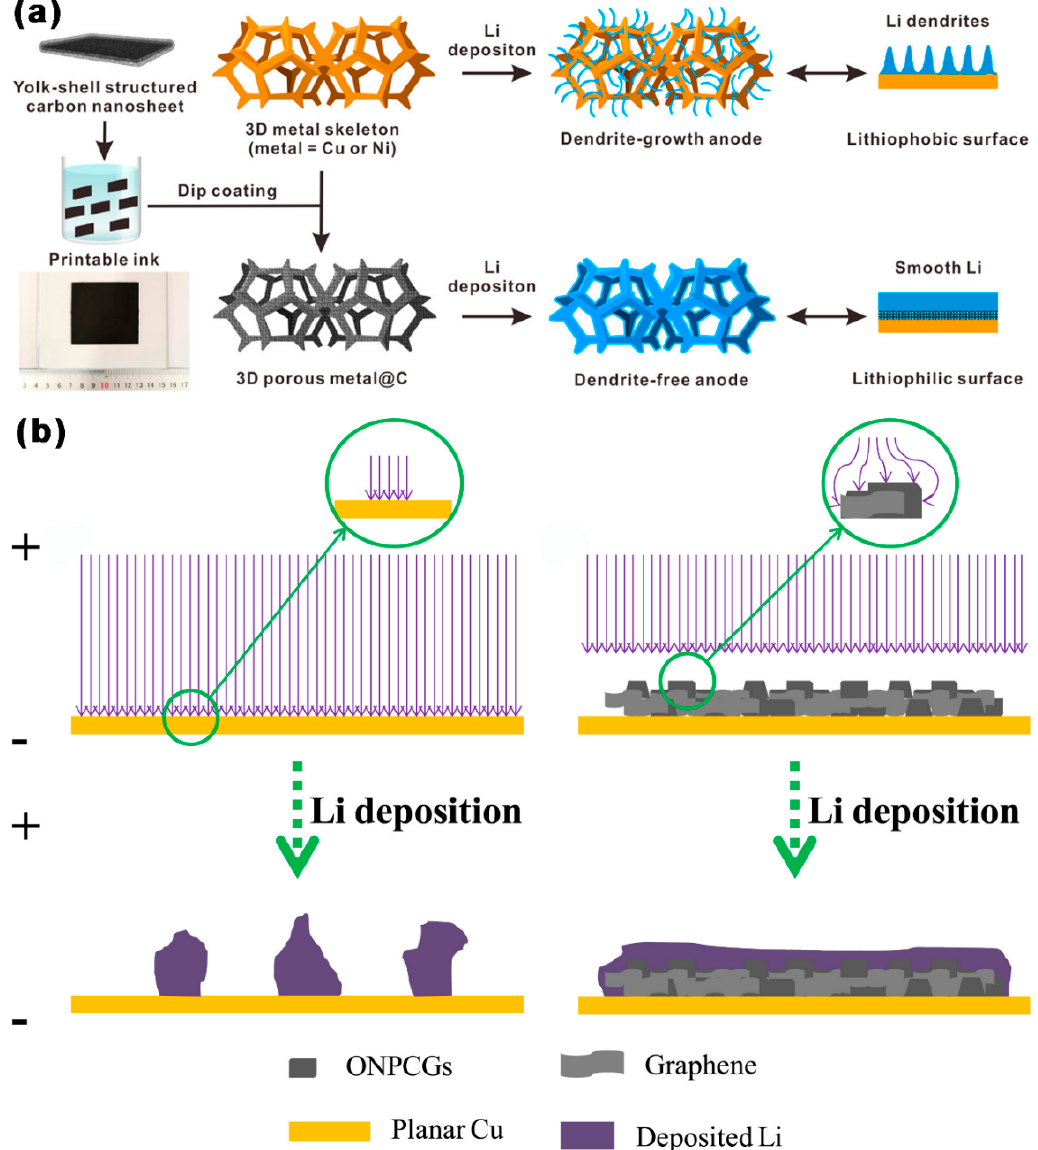
Figure 7. Schematic diagram of Li plating on ( a ) an NPCN-wrapped 3D metal foam [83], and ( b ) a Cu@ONPCG electrode [84].